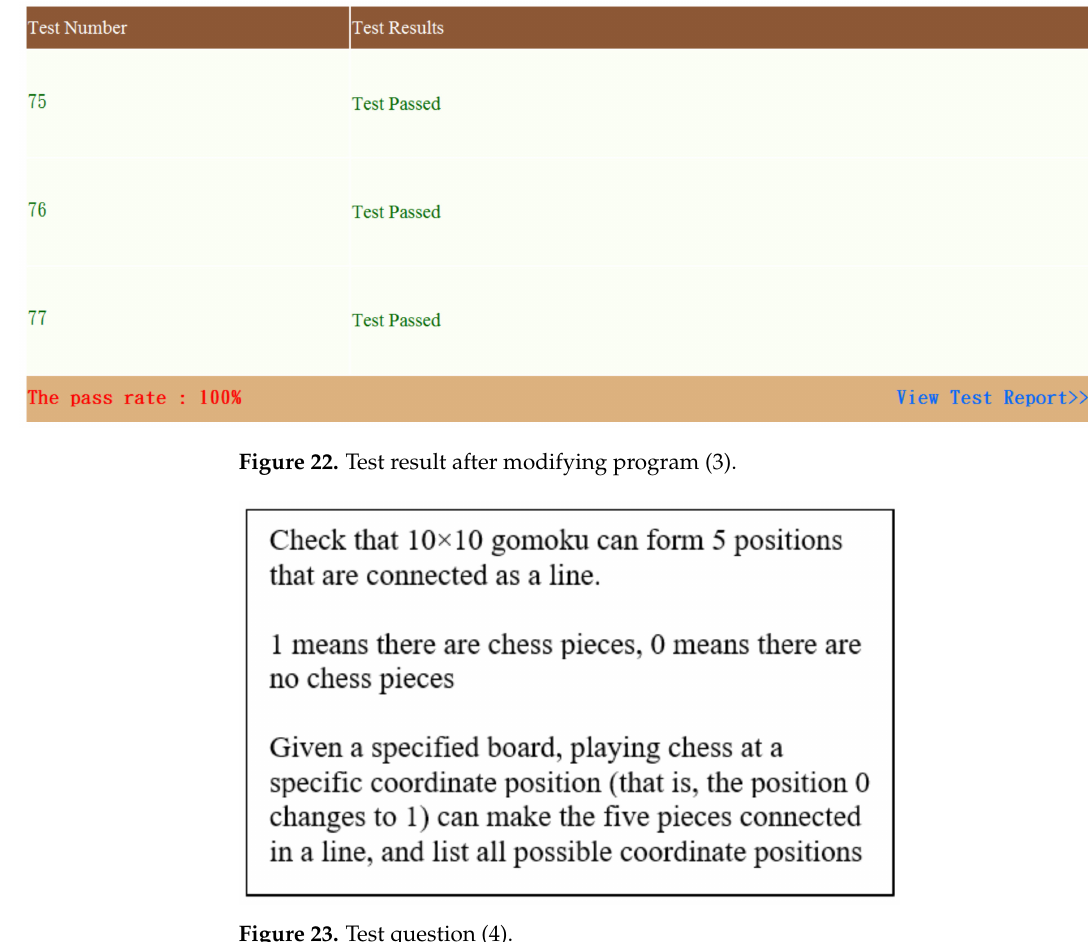
Figure 23. Test question (4). After uploading the sample program in response to this question in the experiment, the test result is shown in Figure 24.